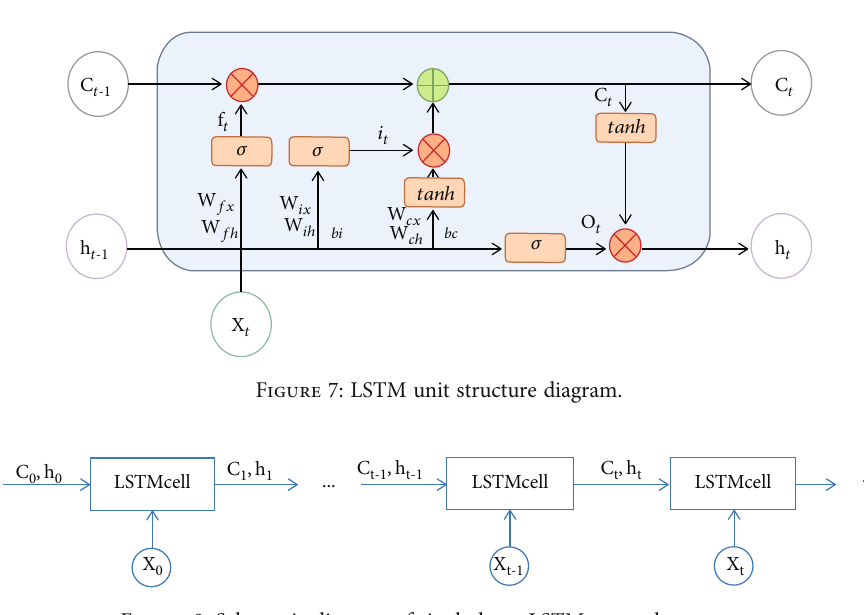
Figure 8: Schematic diagram of single-layer LSTM network structure.